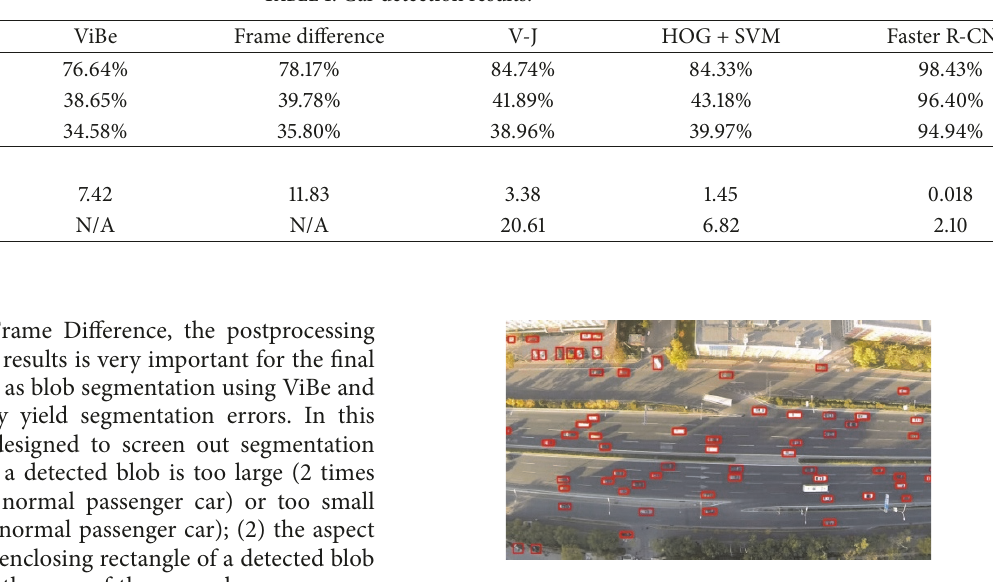
Figure 6: Car detection under illumination changing condition using Faster